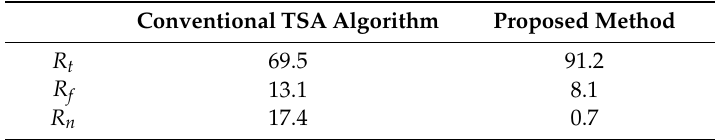
Table 4. Statistical results of track segment association based on radar data